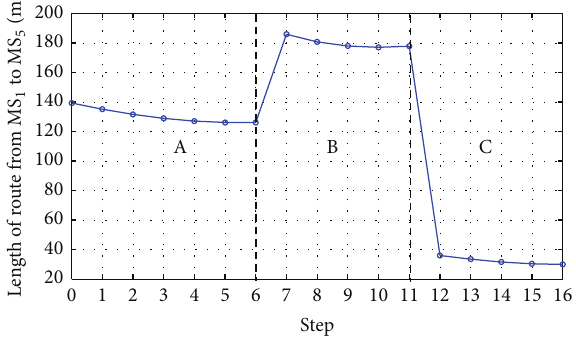
Figure 9: Length of route from MS 1 to MS 5 .